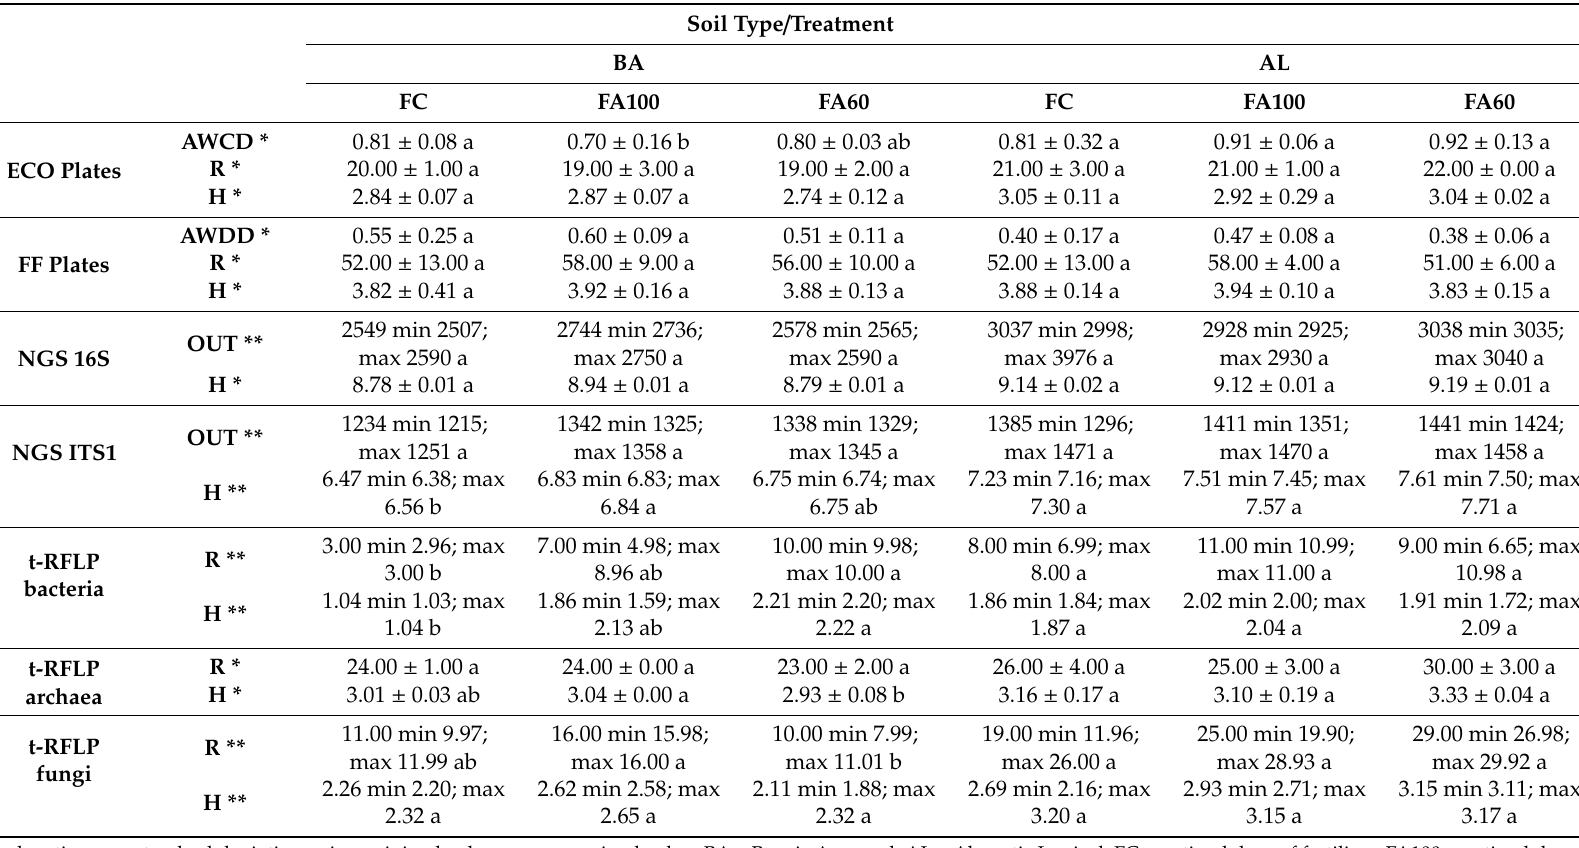
Table 1. Average or median values of AWCD, AWDD, H, R indices and number of OTUs. Different letters indicate significant differences ( p < 0.05) calculated separately for each soil type by ANOVA post hoc Tukey test (AWCD, ECO Plates R, AWDD, FF Plates R, NGS 16S H, t-RFLP archaea R, t-RFLP archaea H), F-Welch and post hoc Tukey test (ECO Plates H, FF Plates H) or Kruskal-Wallis and Dunn test (NGS 16S OTU, NGS ITS1 OTU, NGS ITS1 H, t-RFLP bacteria R, t-RFLP bacteria H, t-RFLP fungi R, t-RFLP fungi